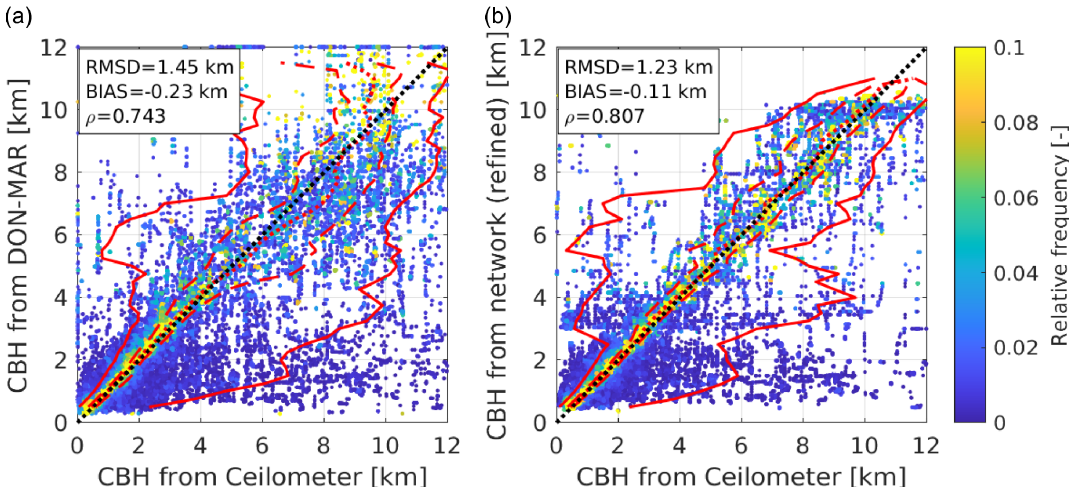
Figure 9. Relative frequency of the CBH from ceilometer for a given ASI-based CBH estimation. Evaluation of the ASI pair, DON-MAR (a) , and of the ASI network with refinements (b) . Subplots ( a ; b ) are created analogously to Fig. 8 ( a ; d ). However, relative frequencies add up to one in each row (not column).